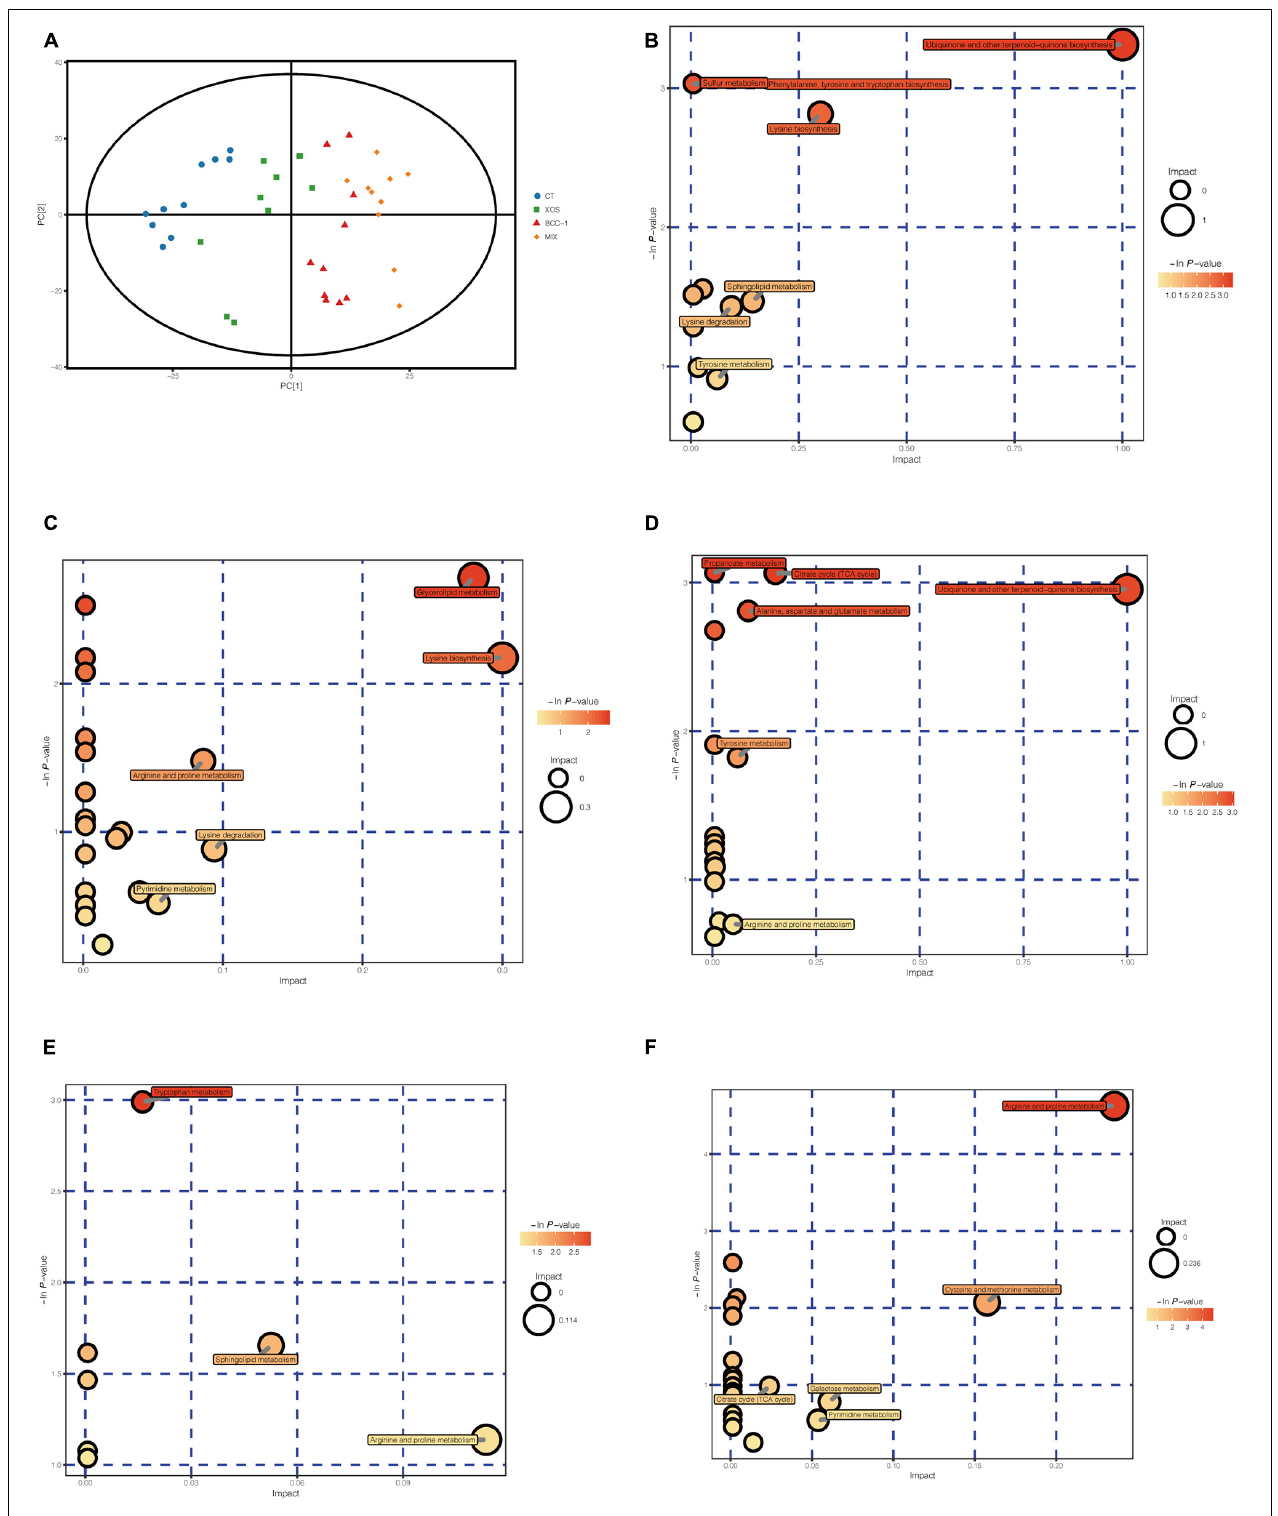
FIGURE 4 | Score scatter plot for PCA model of four groups (A) and differential metabolites enriched metabolism pathways of XOS vs CT (B) , BBC vs CT (C) , MIX vs CT (D) , MIX vs XOS (E) and MIX vs BBC (F) .